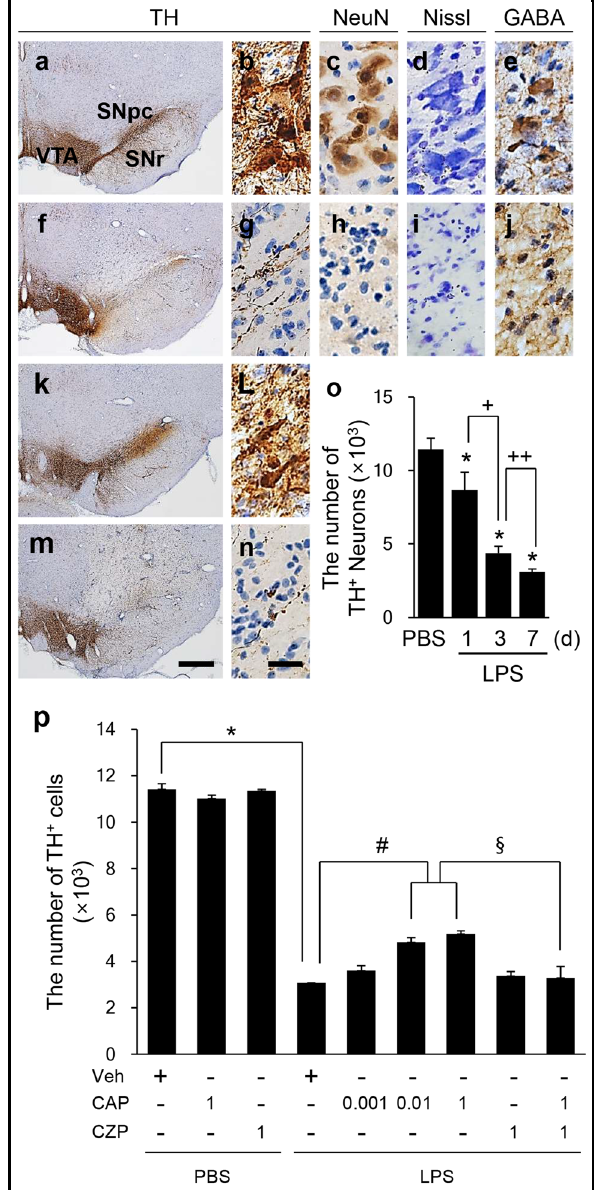
Fig. 1 TRPV1 protected dopaminergic neurons in the SN from lipopolysaccharide (LPS)-induced neurotoxicity in vivo. Phosphate-buffered saline (PBS; a – e ) or LPS ( f – n , 5 µg/3 µl) was unilaterally injected into the SN in the absence ( f – j ) or presence ( k – n ) of capsaicin (CAP; 1 mg/kg, i.p.). CAP was administered 30 min before intranigral injection of PBS or LPS. Capsazepine (CZP; 1 mg/kg, i.p.; m – n ) was administered 30 min before CAP. Animals were sacri fi ced after 7 days; brains were removed, and coronal sections (40 μ m) were prepared using a sliding microtome. Every sixth serial section was selected and processed for TH ( a , b , f , g , k – n ), NeuN ( c , h ), or GABA immunostaining ( e , j ) or for Nissl staining ( d , i ). b , g , l , n , higher magni fi cations of a , f , k , and m , respectively. SNpc, substantia nigra pars compacta; SNr, substantia nigra reticulata; VTA, ventral tegmental area. Scale bars: a , f , k , m , 300 µm; b – e , g – j , l , n , 50 µm. o , p , the number of TH + neurons in the whole SN was counted using a stereological technique at the indicated time points ( o ) and 7 days after LPS ( p ). The data are presented as the mean±SEM of 4 to 8 animals per group. * p < 0.001 compared with PBS-injected SN treated with vehicle; + p < 0.001, ++ p < 0.01 compared with LPS-injected